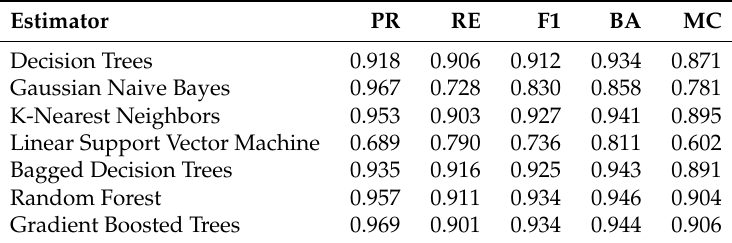
Table 3. Balanced accuracy indices for synthetic data.